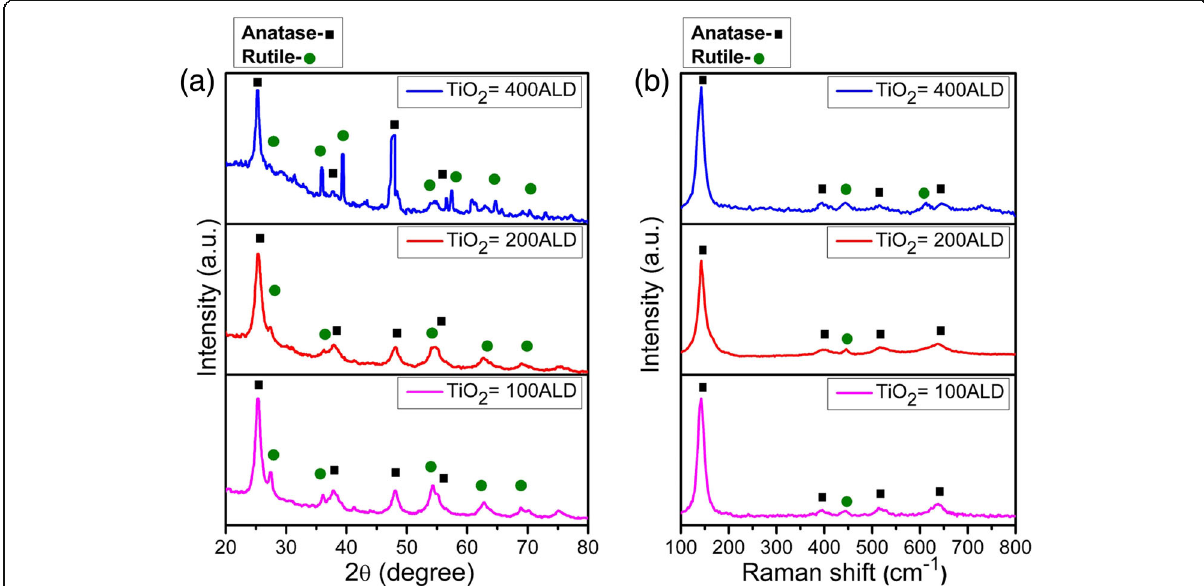
Fig. 2 Micro-structural characterizations of TiO 2 NMs. a XRD patterns of TiO 2 NMs fabricated with 100, 200, and 400 ALD cycles. b Raman spectra of TiO 2 NMs fabricated with 100, 200, and 400 ALD